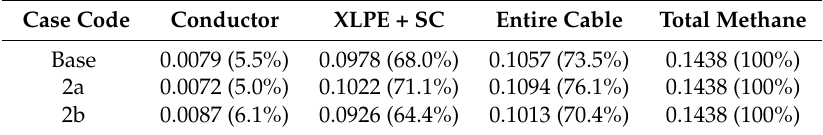
Figure 14. Radial CH 4 concentration profiles for the line speed study at ( a ) the curing tube exit, ( b ) the cable take-up point. Segment (i) corresponds to the conductor layer and segment (ii) corresponds to the XLPE and SC layers. Table 7. Amount of CH 4 (mol/m) present in each cable component at the cable take-up